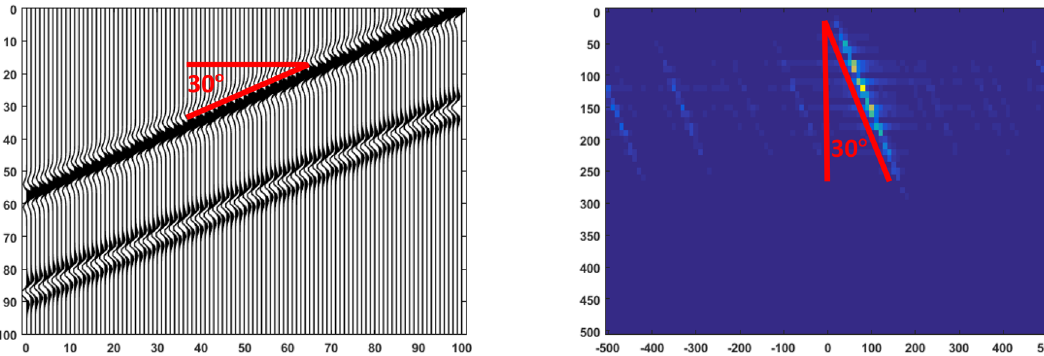
Fig. 1 Section of seismic layers (left) and its spectrum F − K domain